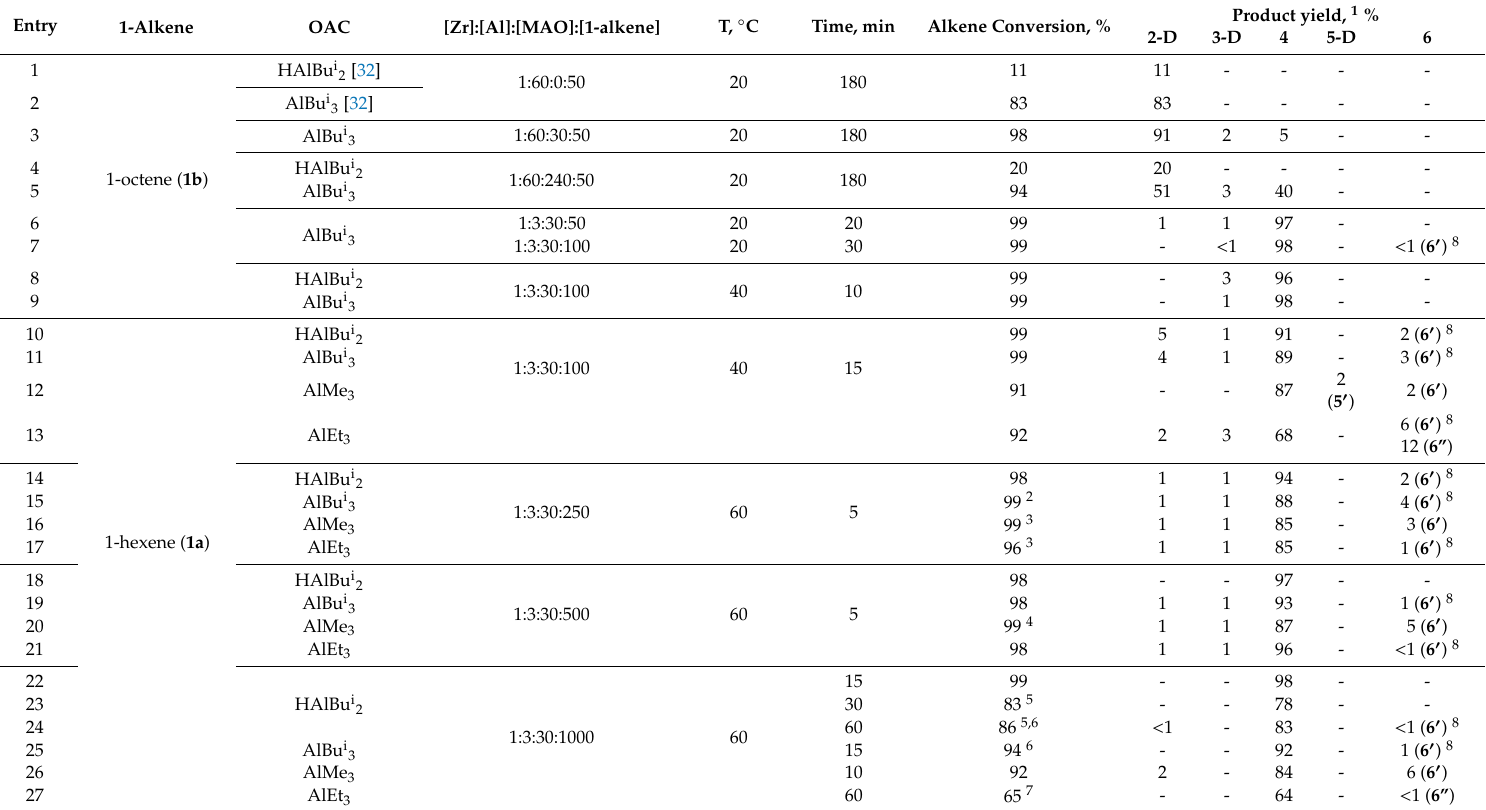
Table 1. Catalytic activity and chemoselectivity of system I Cp 2 ZrCl 2 -OAC-MMAO-12 in the reaction with